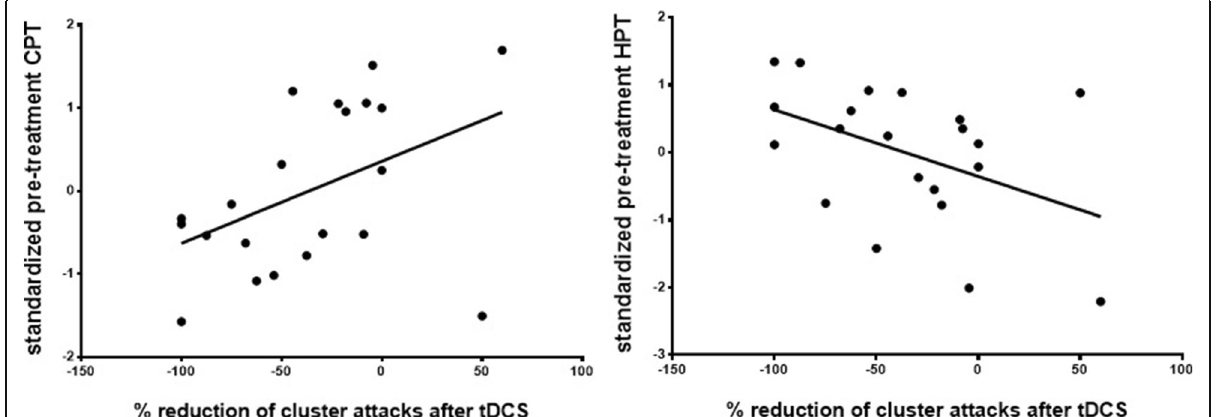
Fig. 5 Correlations between the percentage change in weekly CH attack frequency after daily tDCS (baseline vs. week 4) and the baseline standardized cold (CPT) and heat pain thresholds